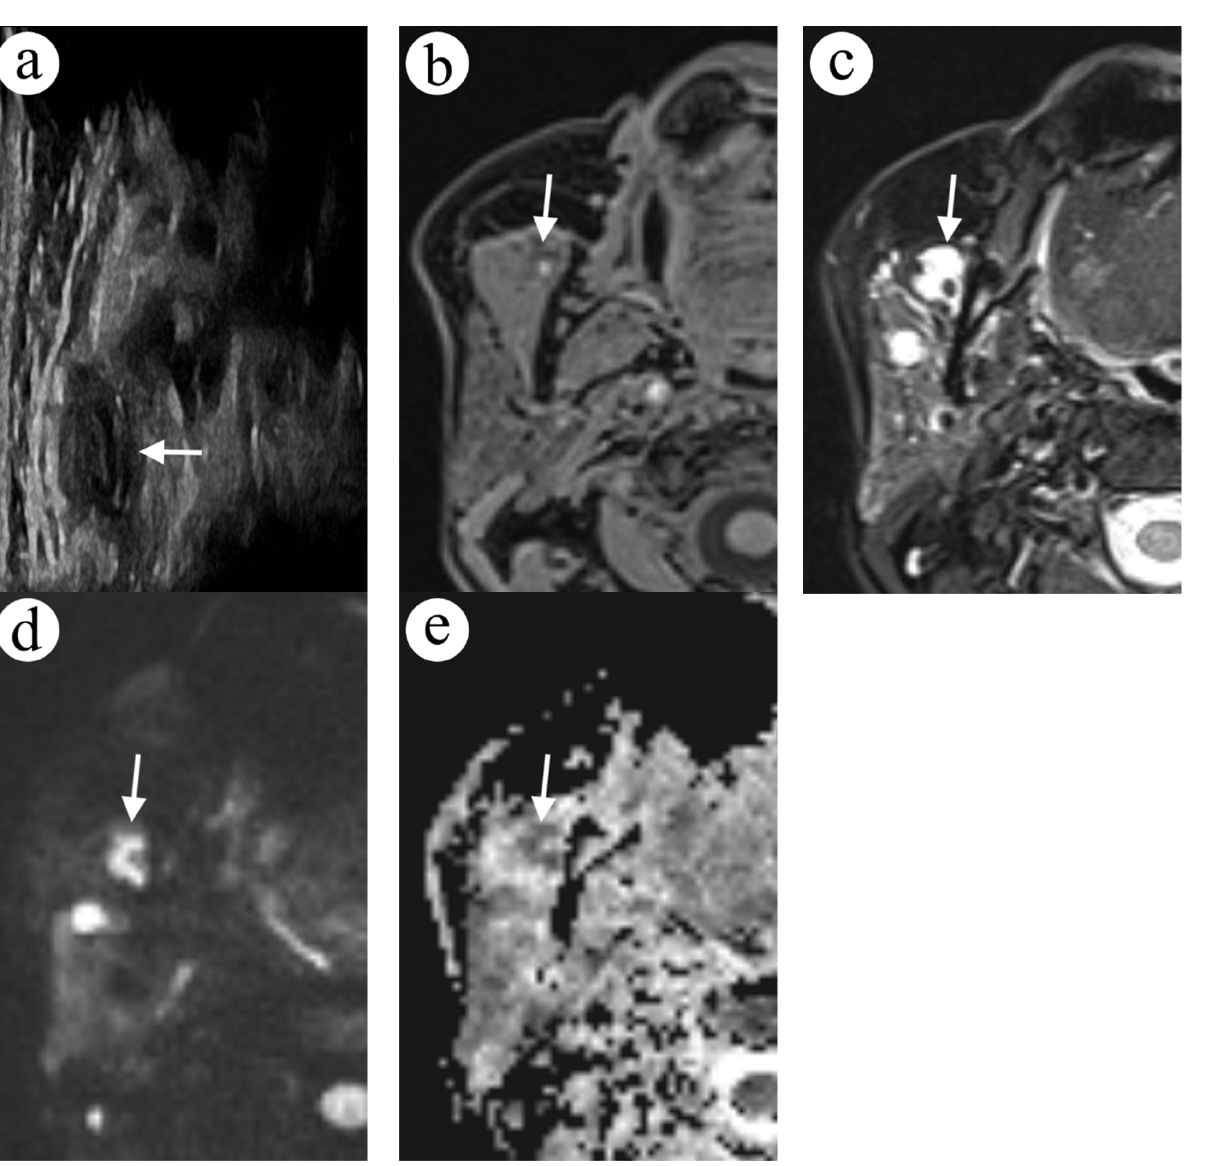
Figure 2. A focal lesion in the anterior process of the right parotid gland in US and MRI; US image is rotated 90 degrees to match the anatomy in MR images. The lesion (arrow) has mixed echogenicity in the US examination ( a ). In the fat-saturated gradient echo sequence (VIBE Dixon) in the axial T1-weighted image, the lesion has mixed intensity with hyperintense foci ( b ). In the fat-saturated turbo spin echo sequence in the axial T2-weighted image, the lesion (arrow) presents as hyperintense ( c ) and shows a rim of diffusion restriction (arrow) in readout-segmented DWI ( d ) and the ADC map ( e ).